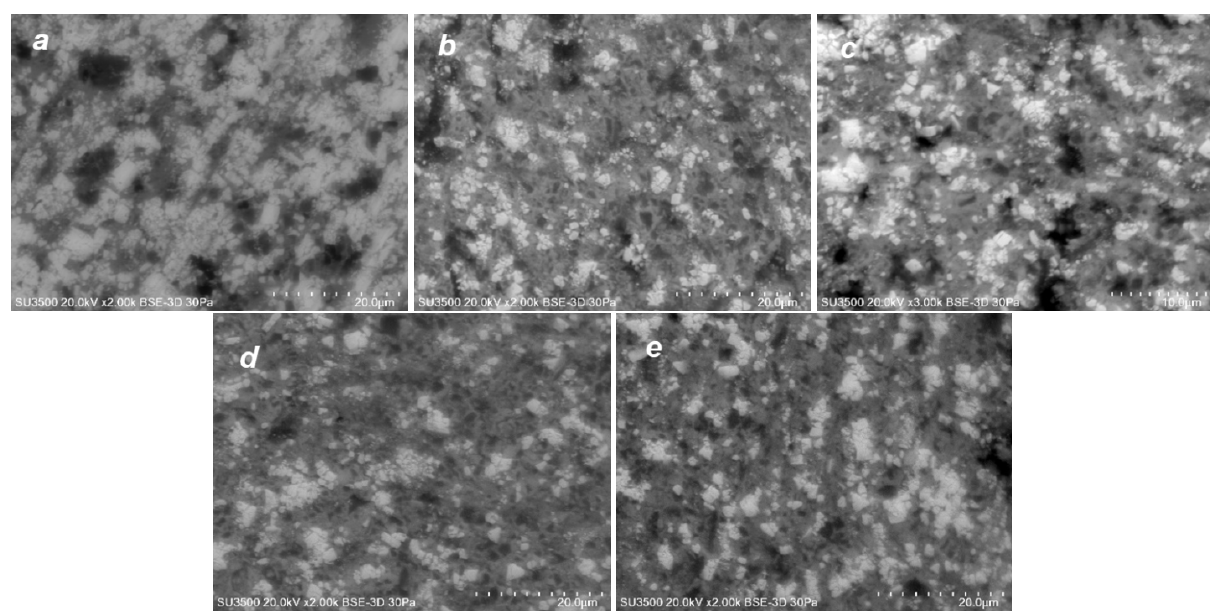
Figure 5: Surface layer’s microstructure of TiC-WC-Ni 3 Al based composites (a-homogeneous, b-n 1 = 0.5, c-n 1 = 1, d-n 1 = 2, e-n 1 =